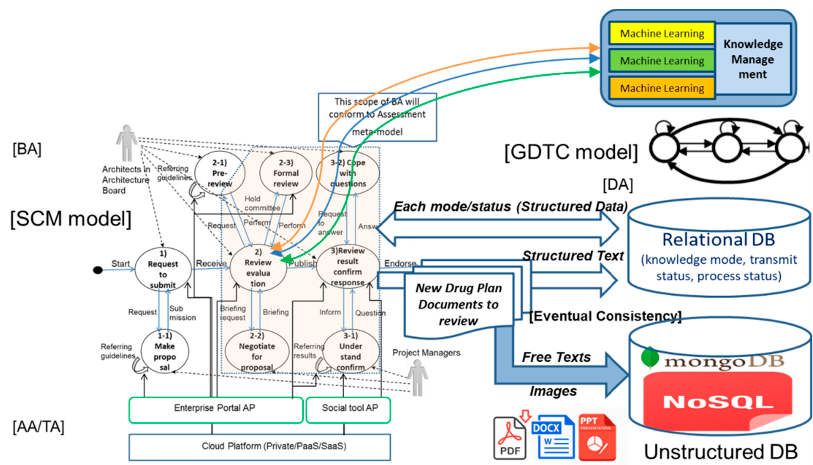
Figure 12. Reference architecture for new drug development review system of drug development platform based on GDTC model and SCM in the AIDAF.